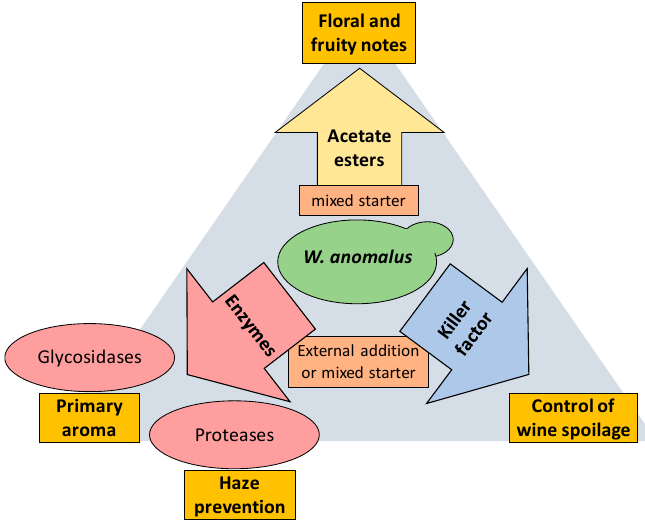
Figure 1. Benefits of Wickerhamomyces anomalus in winemaking.